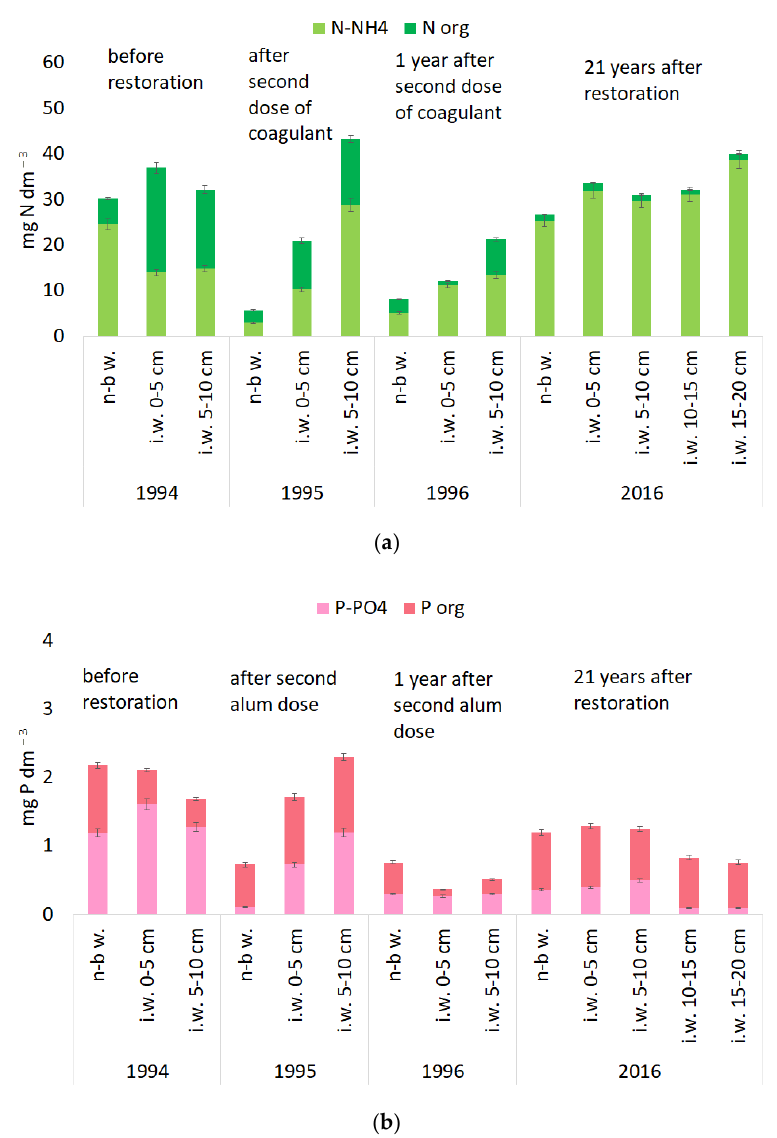
Figure 4. Nutrients concentration (mean ± SD) in the near-bottom water (n-b w.) and interstitial water (i.w.) layers of the water-sediment interface of Starodworskie Lake in 1994, 1995, 1996, and 2016: ( a ) Nitrogen compounds; ( b ) phosphorus compounds. Bars’ heights represent total amount of element.